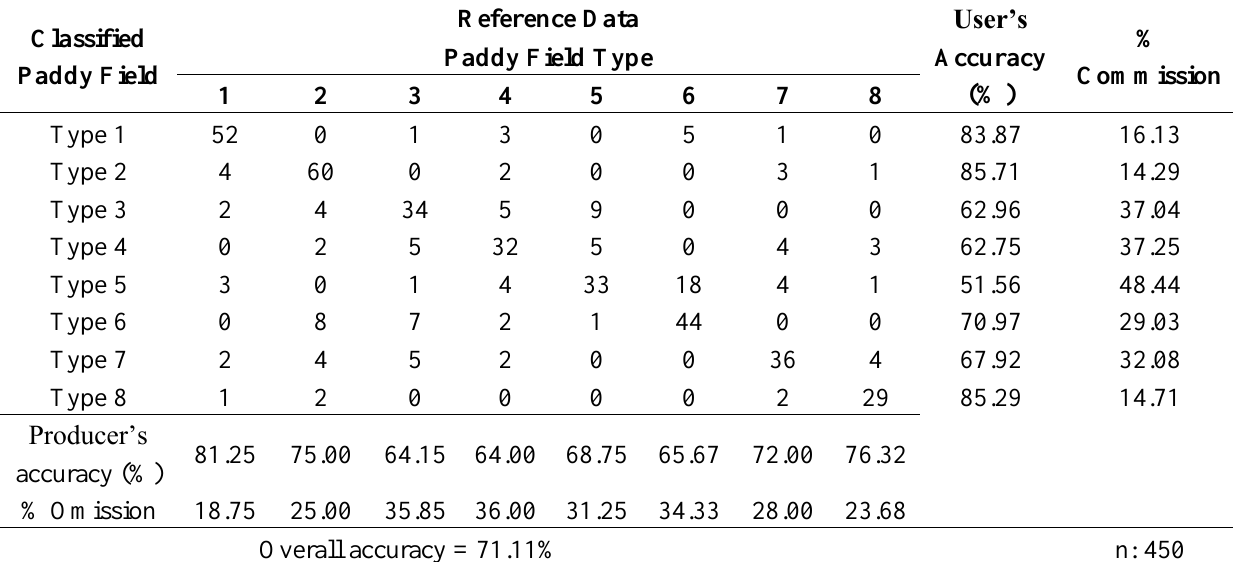
Table 2. Confusion matrix for eight specific types of paddy